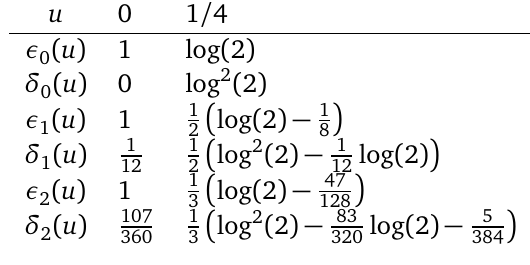
Table 1: Expansion coefficients ε sphere-plane geometry ( u = 0) and of equal spheres ( u = 1 /